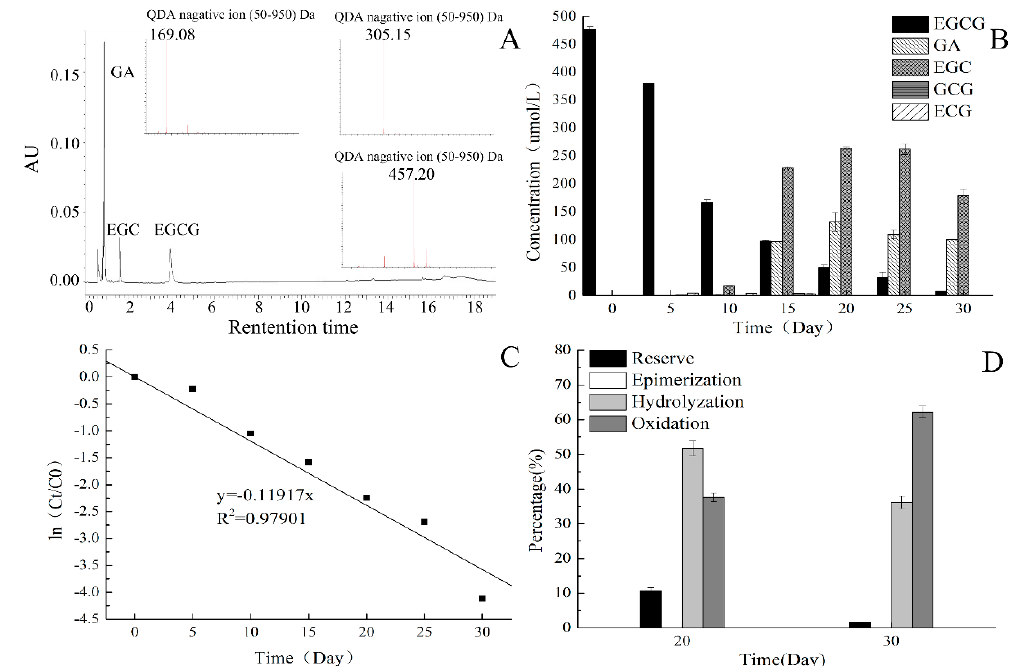
Figure 1. Epigallocatechin gallate (EGCG) stability at 25 °C : ( A ) Chromatograph profile of incubation system stored for 20 days at 25 °C; ( B ) changes in substrates and products during storage of EGCG at 25 °C for 0 to 30 days; ( C ) apparent first-order kinetics of EGCG degradation; ( D ) percentage of the different transformation pathways when EGCG was stored for 20 days and 30 days.